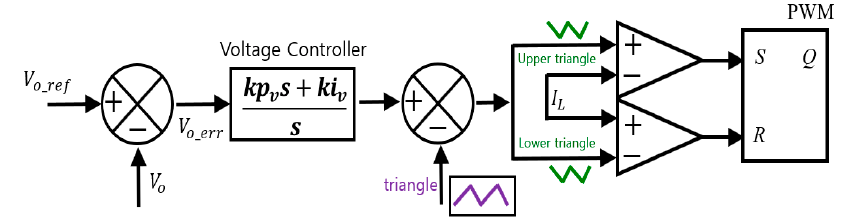
Figure 1. Previousmethod for preventing the sub-harmonic oscillation problem.